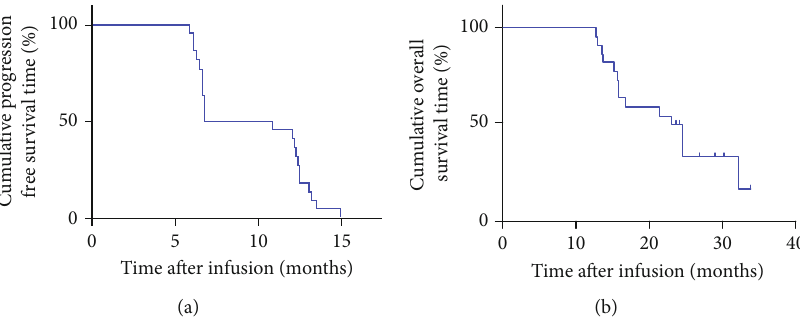
Figure 4: Kaplan-Meier curves for PFS and OS of patients with ORR (CR+PR), N = 22 . (a) The PFS curve of patients with ORR. (b) The OS curve of patients with